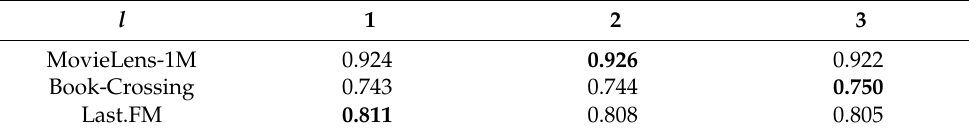
Table 8. Results of AUC on three datasets with different user propagation